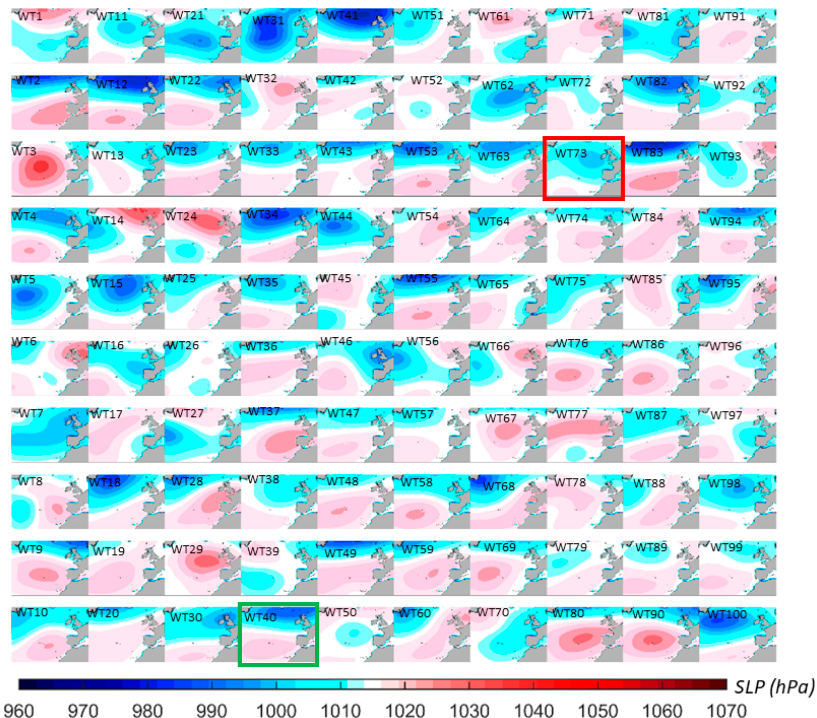
Figure A3. Daily mean SLP associated with each of the 100 weather types of the SD4 model, using a non-guided regression classification. Calibration period: years from 2000 to 2014, excluding 2012, which is the validation period. WT73 and WT40 show the atmospheric pattern of Xynthia (red rectangle) and Joachim (green rectangle) storm, respectively. J. Mar. Sci. Eng. 2019 , 7 , x FOR PEER REVIEW